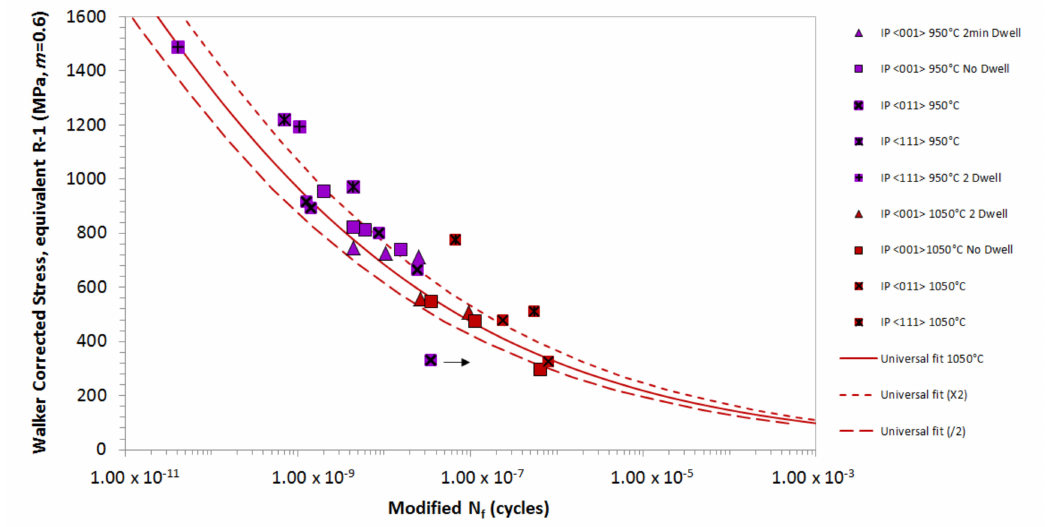
Figure 6. Effect of a single crystal growth orientation on in-phase TMF